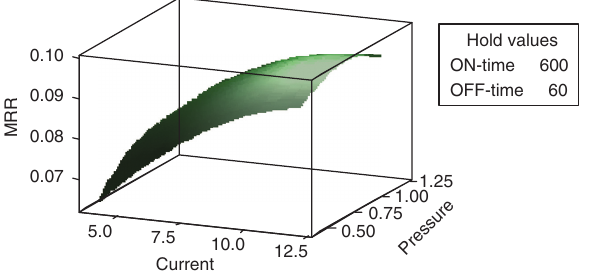
Figure 4 Surface plot of MRR vs. pressure, on time.